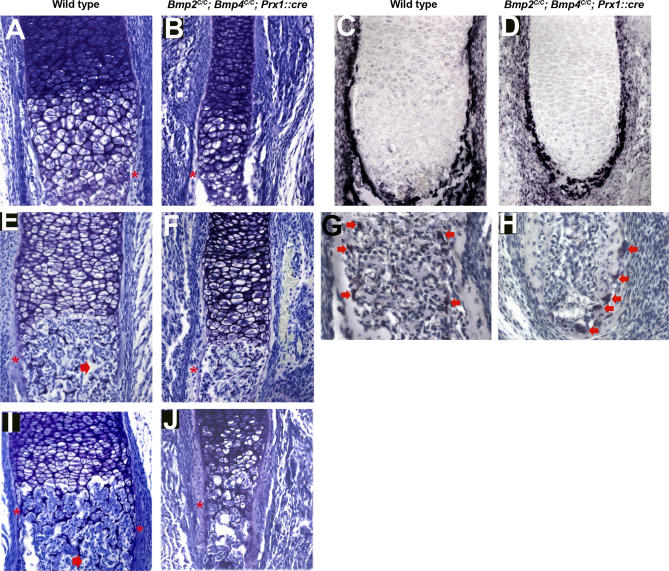
In the Absence of BMP2 and BMP4, Osteogenesis Begins During Early Embryonic Development(A–D) Sagittal sections of forelimb from E15.5 embryos. (A and B) Stained with toluidine blue. (A) Distal ulna from wild-type embryo, (B) distal ulna/radius from Bmp2C/C; Bmp4C/C; Prx1::cre embryo. Mineralized cartilage is shown by dark purple and osteoid is shown by light blue (red asterisk). (C and D) Humeri sections were hybridized with digoxigenin labeled riboprobe for ColI. (C) Section of wild-type humerus from E15.5 embryo, (D) from Bmp2C/C; Bmp4C/C; Prx1::cre E15.5 embryo.(E–H) Sagittal sections of zeugopod from E17.5 embryos. (E and F) Stained with toluidine blue while G and H are stained for TRAP (brown stain, red arrow). (E and G) E17.5 proximal radius from wild-type embryo, (F and H) E17.5 proximal ulna/radius from Bmp2C/C; Bmp4C/C; Prx1::cre embryo. Although vascularization occurs in the absence of BMP2 and BMP4, few osteoclasts are observed in the mineralized cartilage in Bmp2C/C; Bmp4C/C; Prx1::cre mice. Please note all the panels other than (G) and (H) are photographed at ×20, while (G) and (H) were photographed at ×40.(I and J) Sections of newborn proximal radius (I) from control animal and newborn proximal ulna/radius (J) from Bmp2C/C; Bmp4C/C; Prx1::cre animal were stained with toluidine blue. Red arrow shows the bone marrow cavity in (E) and (I). Note that bone collar (red *) forms at the right time and place in the absence of BMP2 and BMP4. Also note that since Bmp2C/C; Bmp4C/C; Prx1::cre mice occasionally have only one bone in zeugopod and the elbow joint is occasionally fused, it is difficult to distinguish between the ulna and the radius.